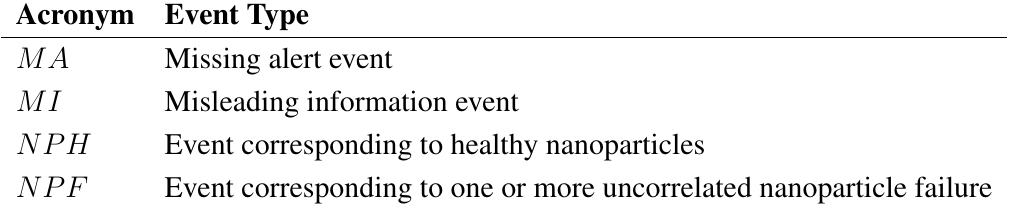
Table 1. Acronyms used for the computation of the hazardous misleading information (HMI)